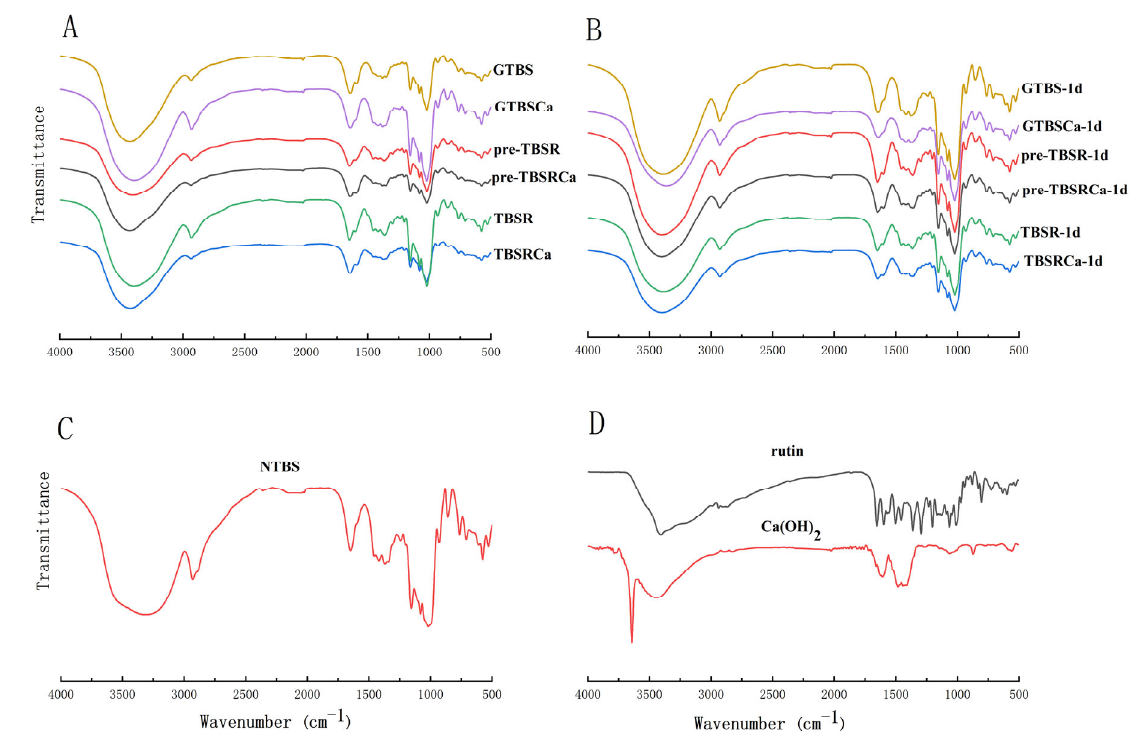
Figure 5. FTIR spectra of the GTBS, GTBSCa, pre-TBSR, pre-TBSRCa, TBSR and TBSRCa complexes ( A ) and retrograded samples for 1 day ( B ); NTBS ( C ); rutin and Ca(OH) 2 ( D ).